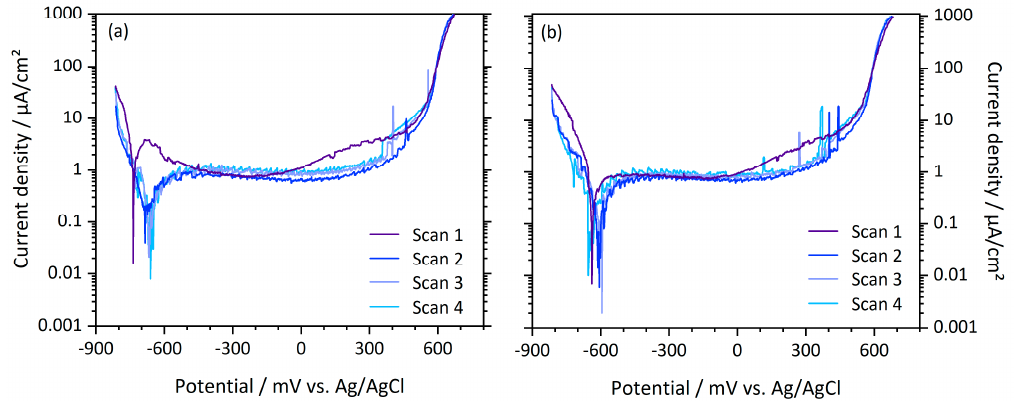
Figure 8. Anodic polarization curves of ( a ) a polished and ( b ) a microblasted CoCrMo sample tested in PBS.